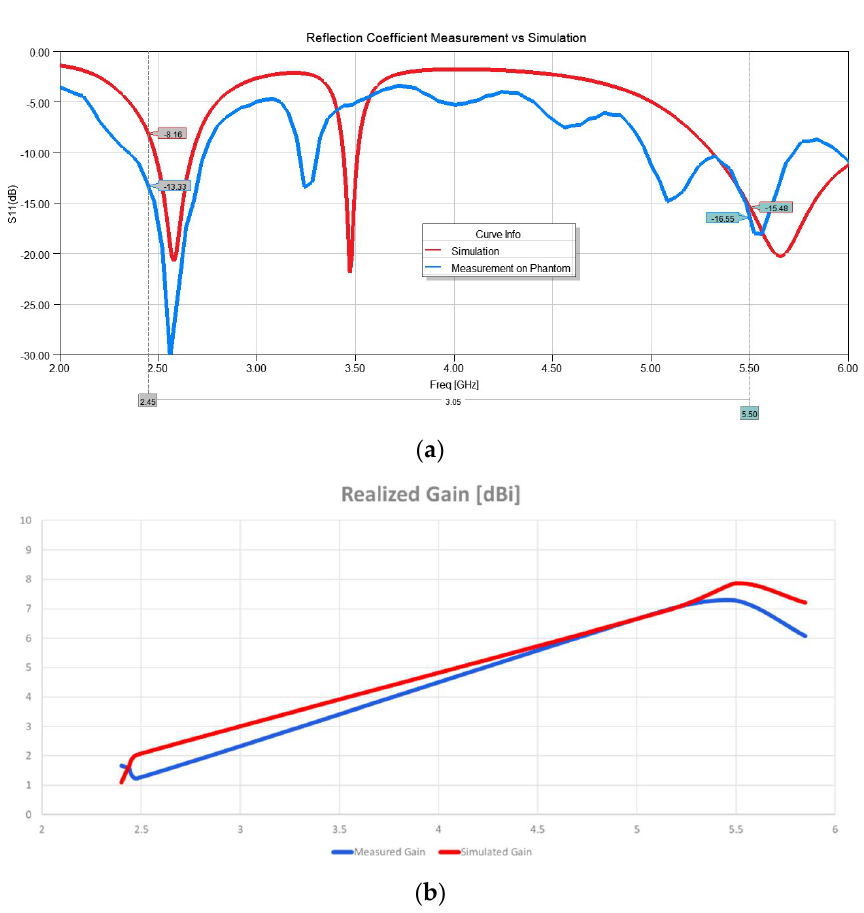
Figure 10. Antenna measurement on phantom : ( a ) S11 measured vs. simulated; ( b ) gain measured vs. simulated.